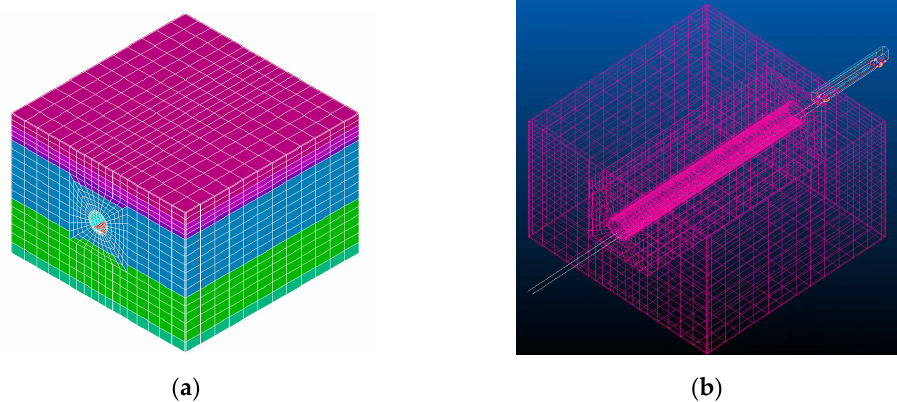
Figure 5. 3D vehicle tunnel coupling model: ( a ) ANSYS model of the tunnel and soil and ( b ) vehicle tunnel coupling model in VI-RAIL.